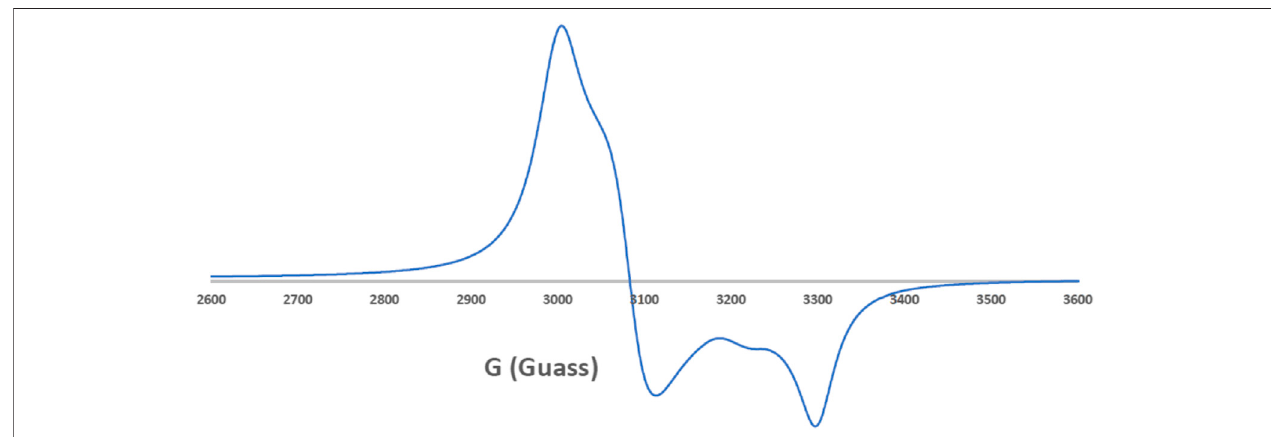
FIGURE 2 | EPR spectrum of the Cu – SCZ complex.